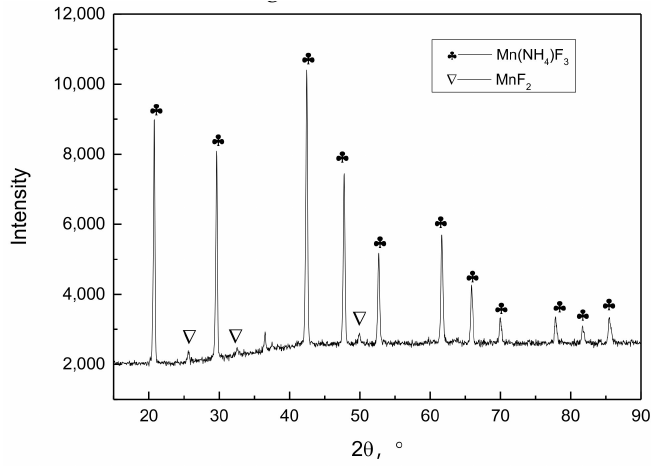
Figure 7. X-ray diffraction (XRD) pattern of the composite reagent for removing